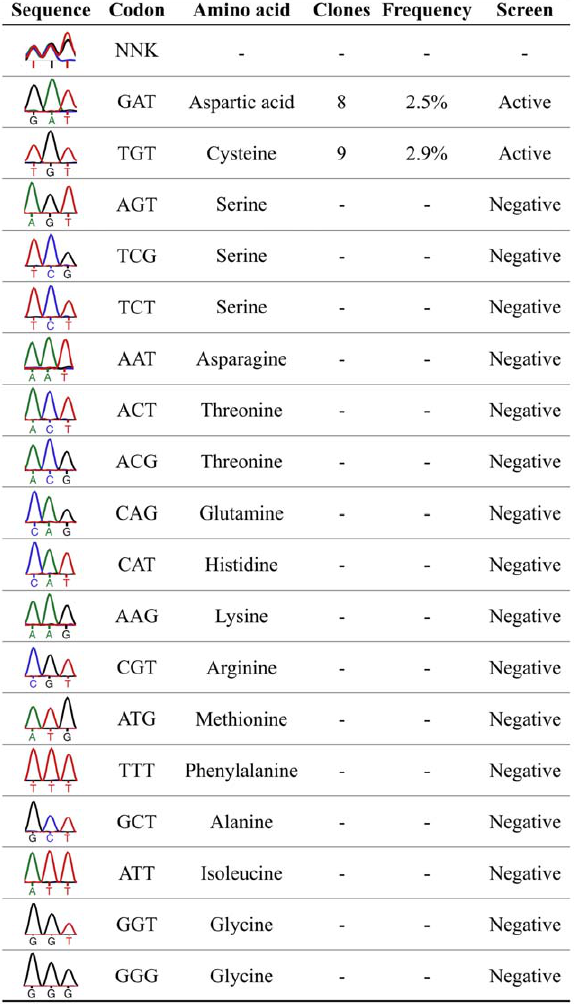
Figure 3. Sequencing of the randomized library, of all active clones and of a representative subset of negative clones. DNA sequencing revealed that only aspartic acid, encoded by the codon GAT, was able to functionally replace cysteine 298. Back mutations to cysteine were also observed. Frequencies (for active clones only) were calculated as the ratio between the number of clones with the specific codon and the total number of screened clones. The results of the sequencing of the whole randomised library and of a representative subset of negative clones are shown.